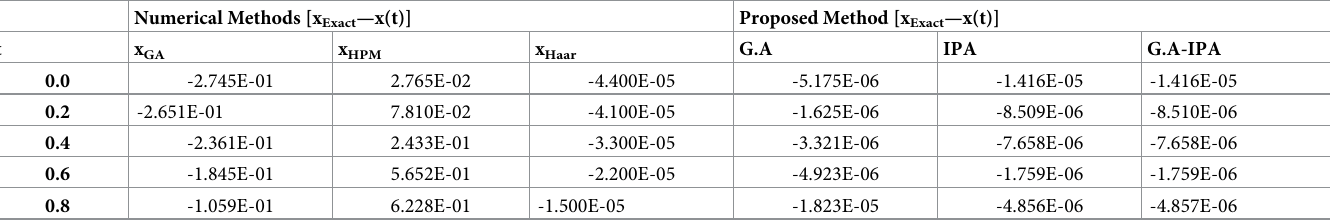
Table 17. Comparison of absolute errors between numerical methods and proposed method for δ =